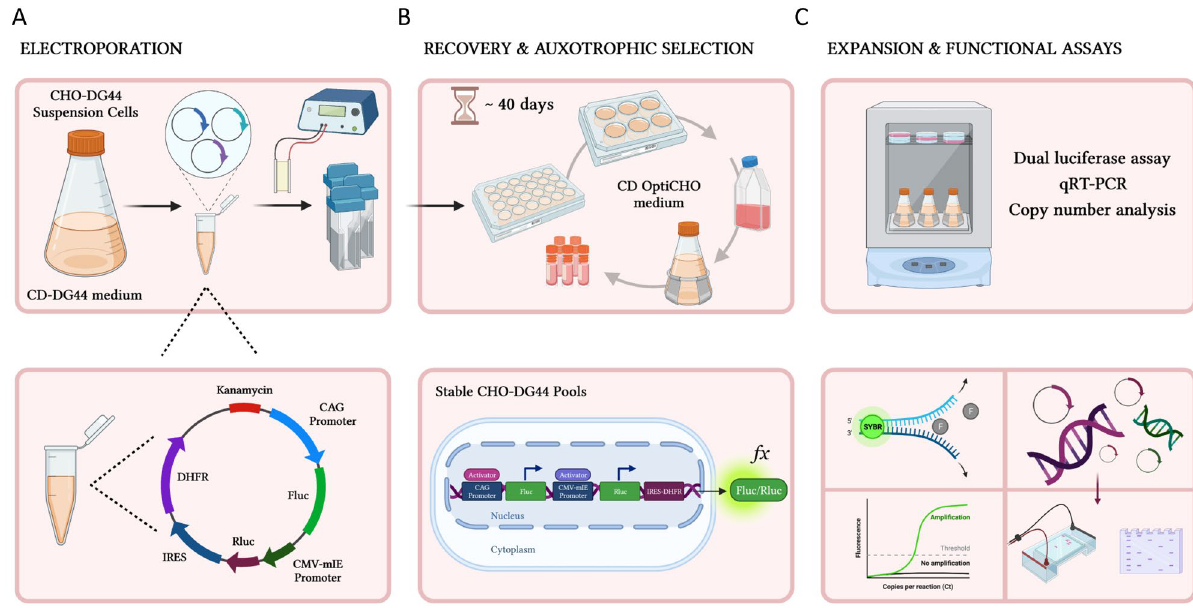
Figure 4. Schematic representation of stable CHO-DG44 cell line development. ( A ) Electroporation: CHO-DG44 suspension culture was electroporated with the vector panel. The constructs harbor variable promoters (the CAG promoter is exemplified in this vector map) upstream of the Fluc coding sequence, followed by the CMV-mIE promoter, Rluc gene, IRES sequence and DHFR gene, as well as the Kanamycin resistance gene as the bacterial selection marker. ( B ) Recovery and auxotrophic selection: Selection was carried out in CD OptiCHO selection media, by sequentially transferring individual CHO-DG44 pools into 6-well plates, T25 flasks and higher volume shake flasks based on their cell division frequency and selection recovery. DHFR based auxotrophic selection took roughly 40 days and cells were occasionally cryopreserved after recovery. ( C ) Expansion and functional assays: After clonal expansion of stable CHO-DG44 pools in HT deprived media, dual luciferase assay, qRT-PCR based gene expression analysis as well as qPCR based copy number experiments were executed. The schematics are created with